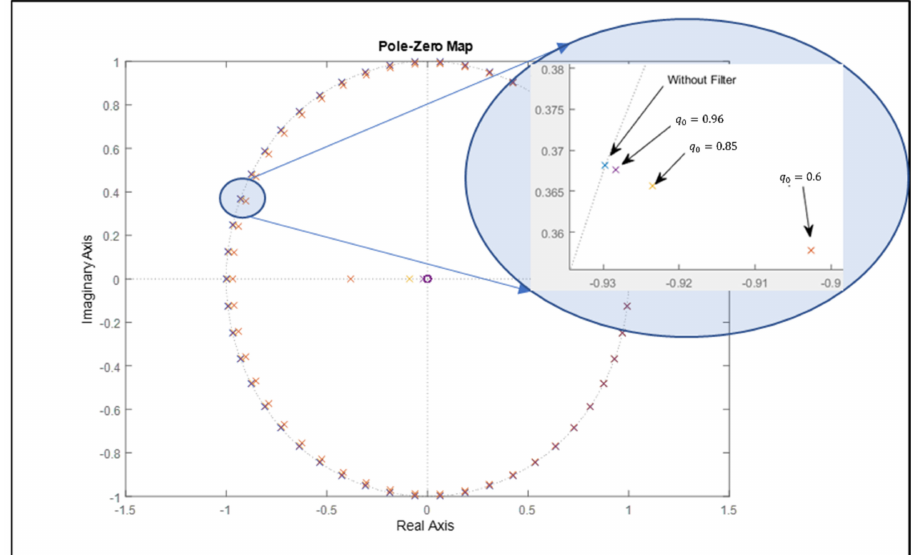
Figure 15. Pole diagram with zeros of the internal model with filter (red, yellow, purple) and without filter